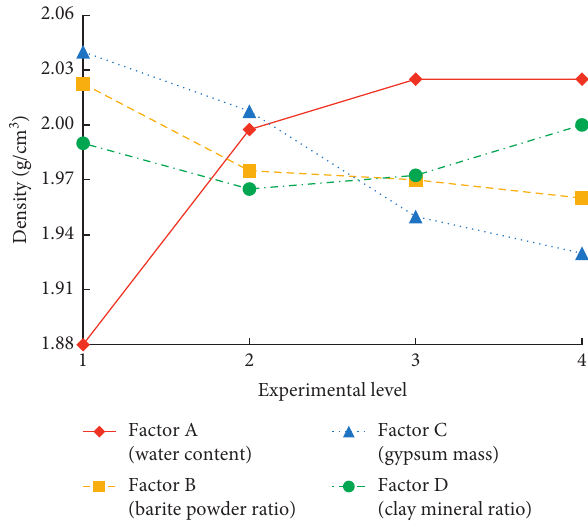
Figure 5: Range analysis of the factors affecting